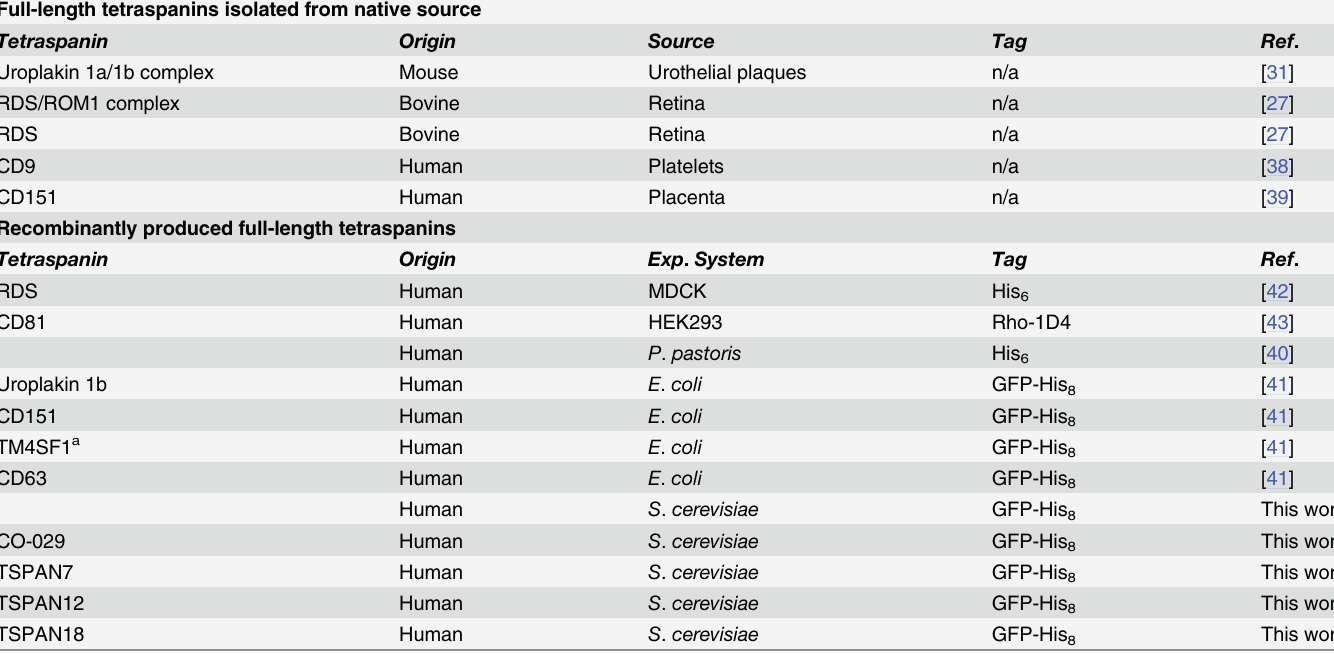
Table 1. Experimental studies reporting tetraspanin production or isolation. MDCK, Madin-Darby Canine Kidney Epithelial Cells; HEK293, Human Embryonic Kidney 293 cells Full-length tetraspanins isolated from native